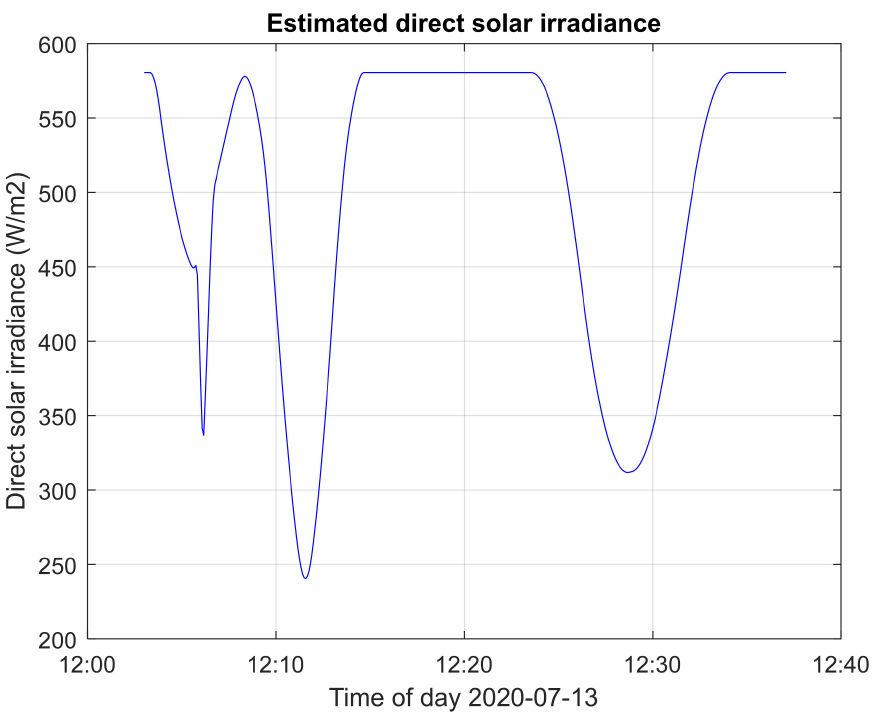
Figure 21. Predicted level of direct solar irradiance on 13 July 2020 from 12:00 until